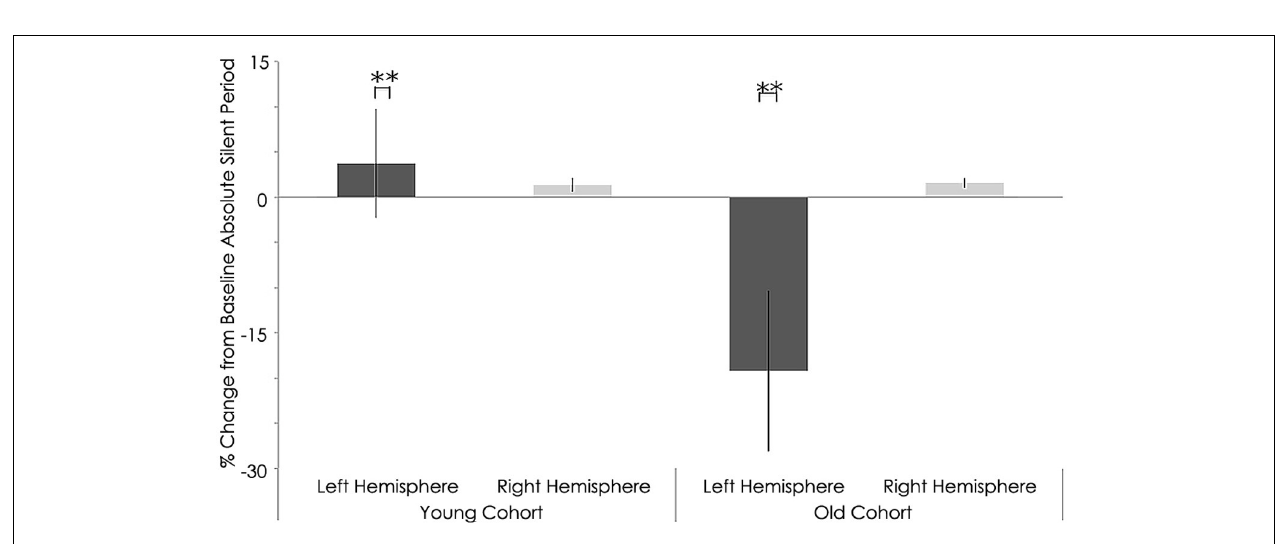
FIGURE 9 | Interhemispheric characteristics measure as absolute silent period (ms) of the study sample after rTMS. Statistically significant increased in absolute silent period among young subjects ( p = 0 . 001;